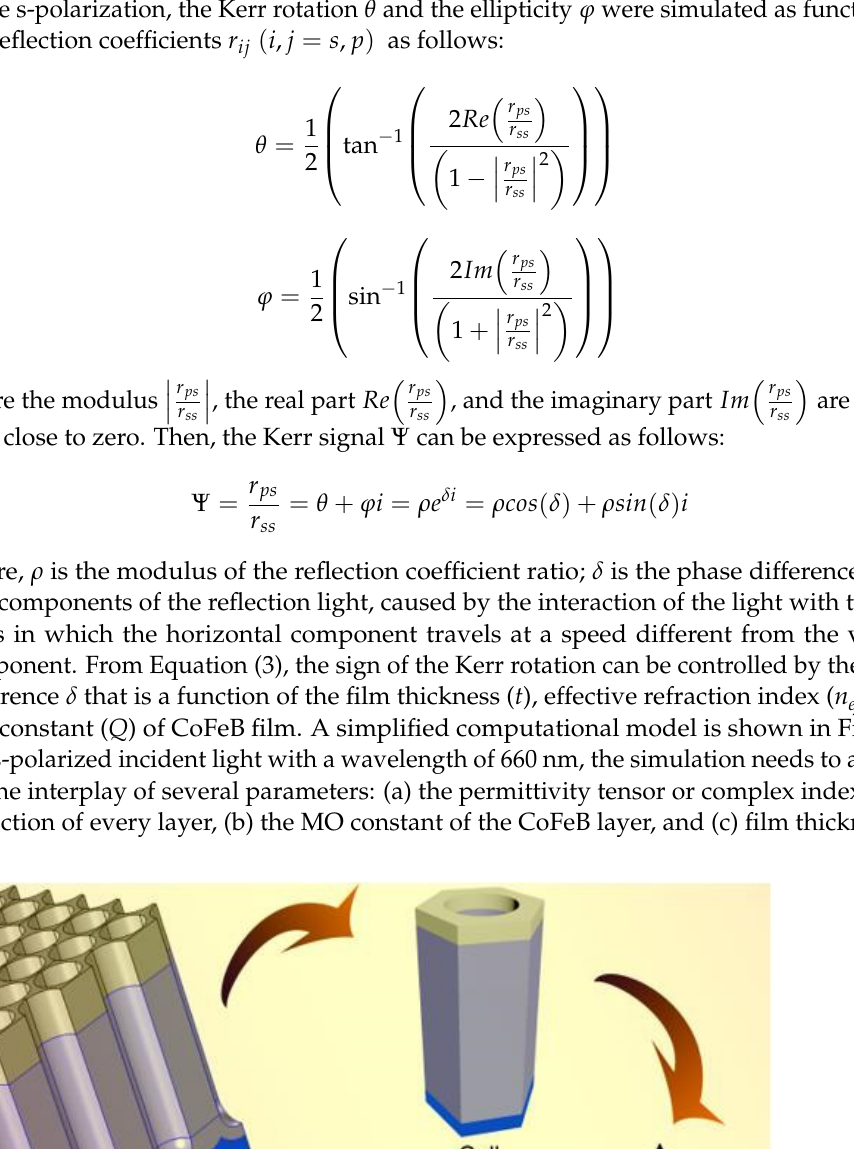
(cid:42) E, external